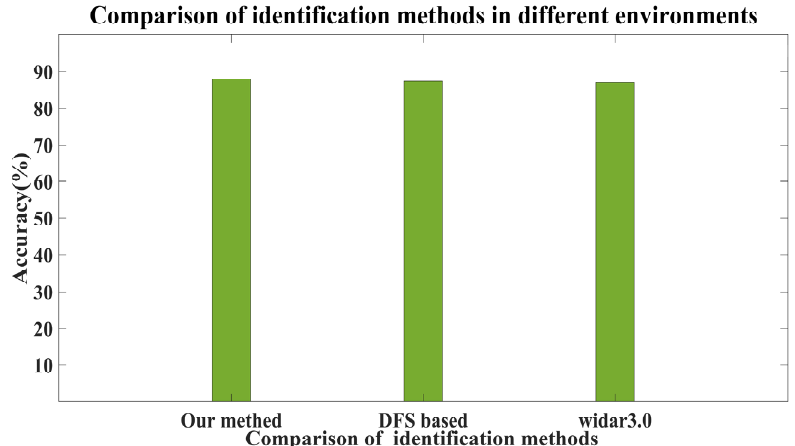
Figure 15. Comparison of methods in different environments.